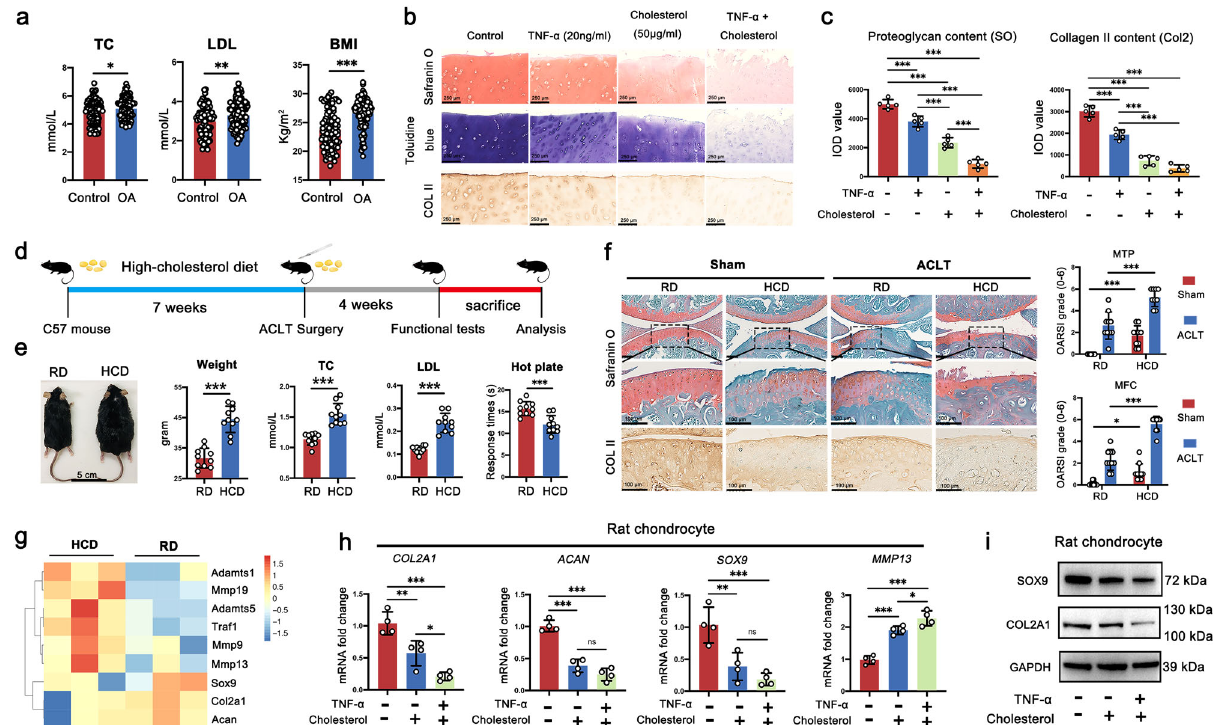
Fig.1|HighcholesterolaggravatesOAcartilagedegeneration.a Levelsofserum totalcholesterol(TC),low-densitylipoprotein(LDL),and bodymassindex(BMI)in OA ( n =100) or meniscal injured (as control) patients ( n =91) (unpaired two-tailed Student ’ s t -test). b Safranin-O, toluidine blue, and type II collagen immunohis- tochemistry (IHC) staining in human cartilage explants treated with cholesterol (50 μ g/ml)and/orTNF- α (20ng/ml)for14d( n =5). c Theintegratedopticaldensity (IOD) value for proteoglycan content and type II collagen (COLII) determined by safranin O and immunohistochemistry staining ( n =5, one-way ANOVA). d Scheme ofthehigh-cholesteroldiet(HCD)feedingandACLTsurgeryinmice. e Thegeneral view, body weight, serum TC, serum LDL, and pain response times of HCD mice compared with RD mice ( n =10, two-tailed Student ’ s t -test). f Representative